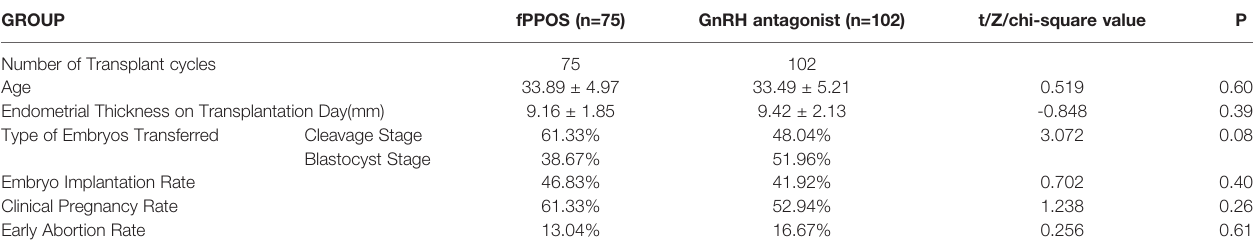
TABLE 4 | Data of freeze-thaw transplantation cycle and reproductive outcome between the two groups. GROUP Number of Transplant